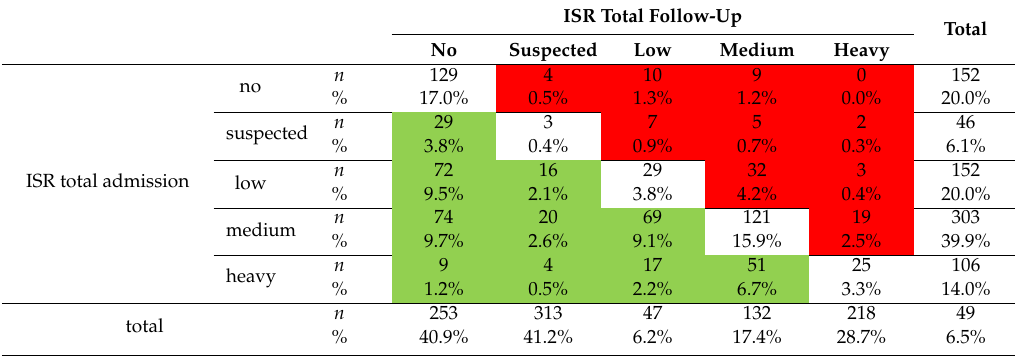
Table 4. Cross-classified table of the change in symptom classification between admission and follow-up.